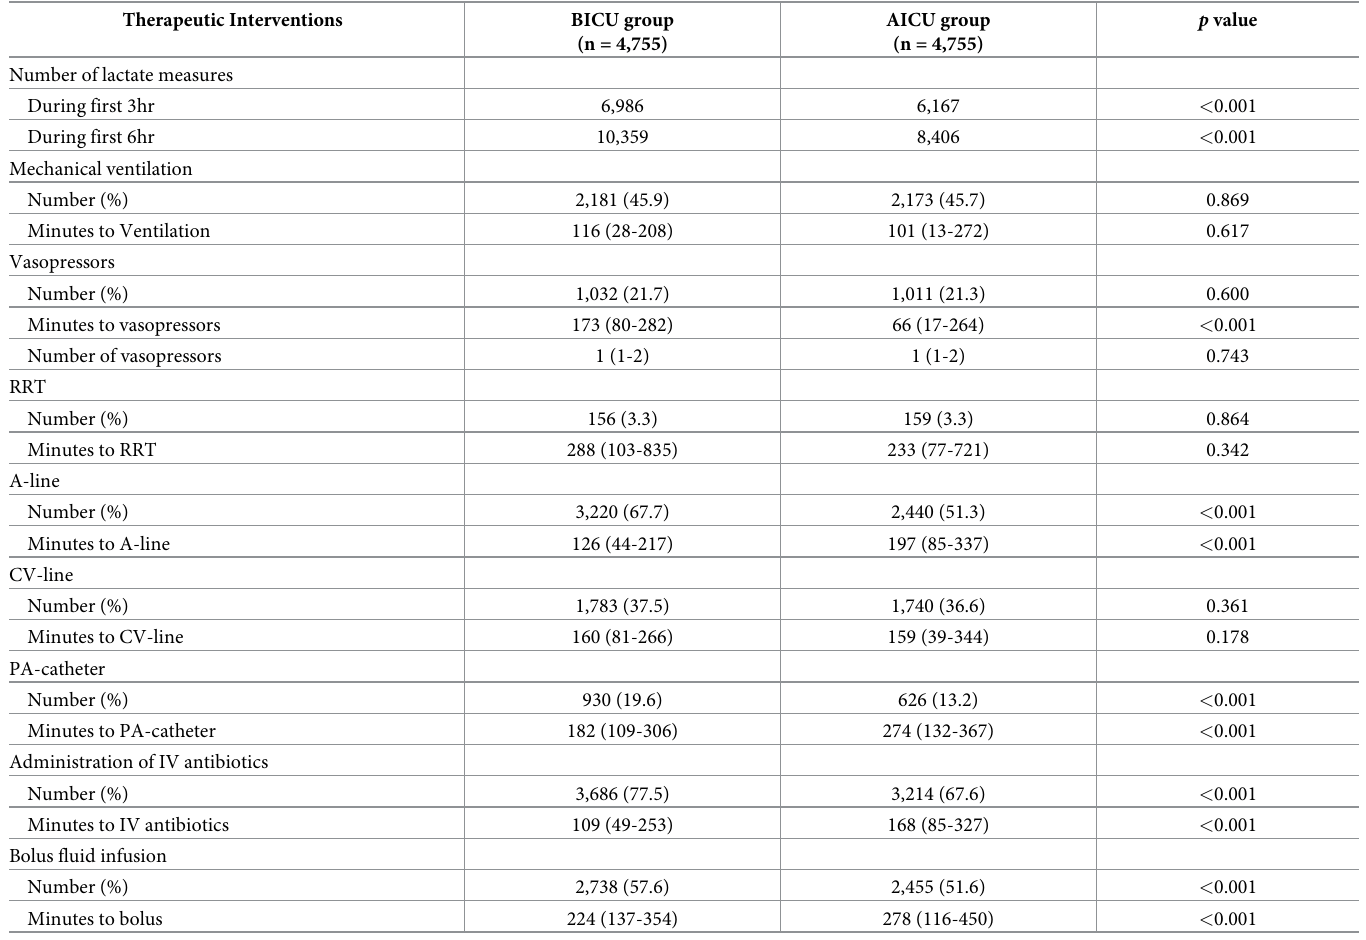
Table 4. Comparisons of therapeutic intervention during first 24h after ICU admission in the PSM cohort. Therapeutic